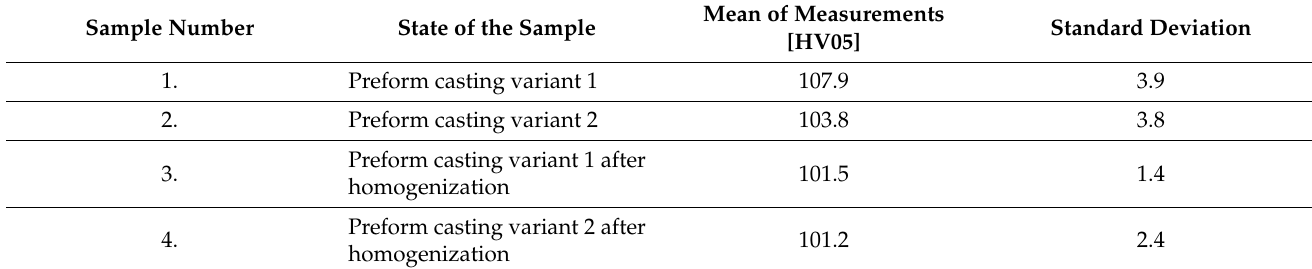
Table 4. Results of hardness measurements of the connecting rod preforms and forgings made of AB-71100